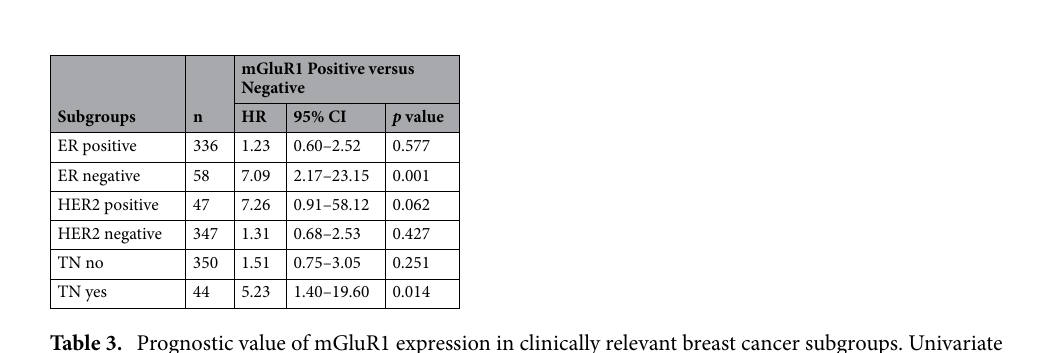
Table 3. Prognostic value of mGluR1 expression in clinically relevant breast cancer subgroups. Univariate cox-regression analysis of MFS in different breast cancer subgroups (as retrieved from TMA).